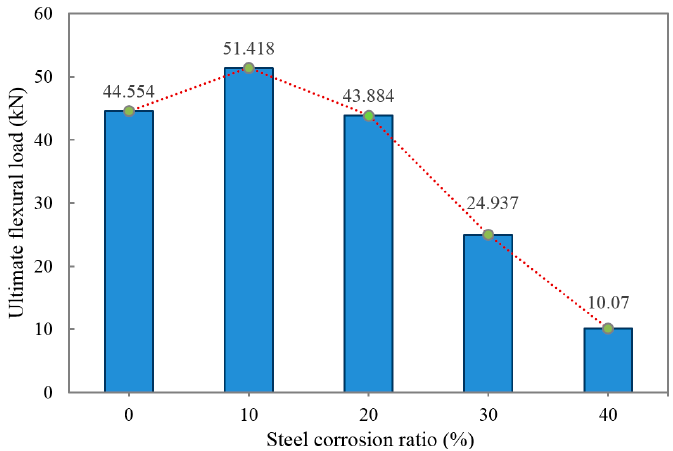
Figure 8. Ultimate flexural load.